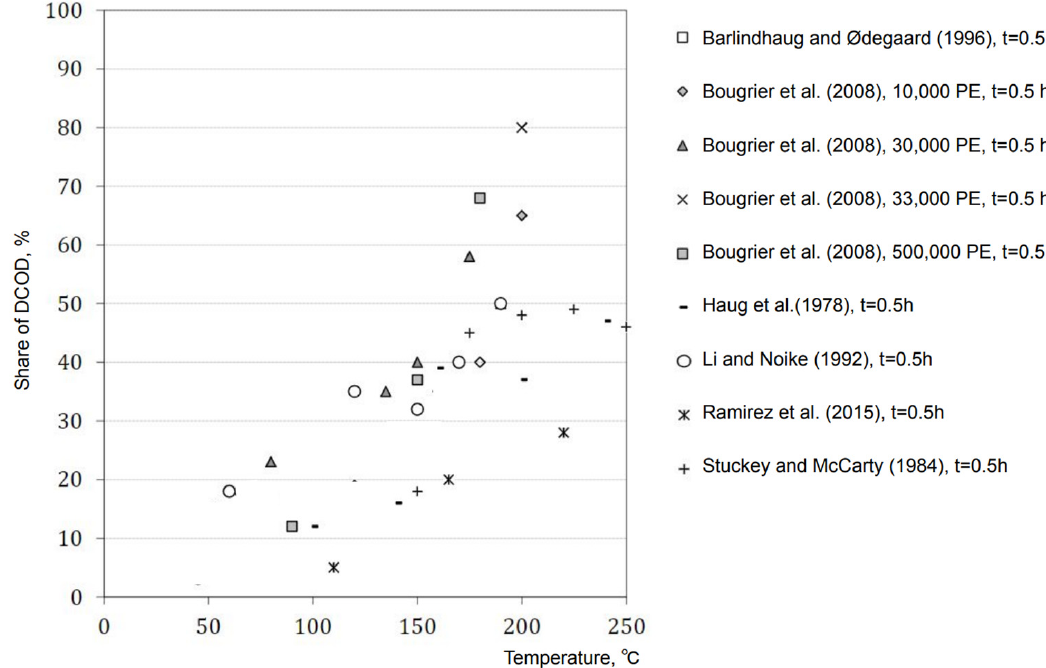
Figure 2. Share of the COD-dissolved fraction in sewage sludge COD depending on the temperature of the disintegration process (summarized literature resource by Author) [14,28,35,36,39,47].